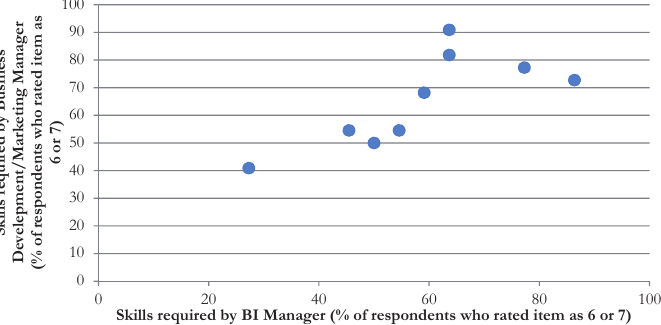
Fig. 4 – Correlation between comparable variables from BIM and BDO/Marketing Manager roles. Source: authors.